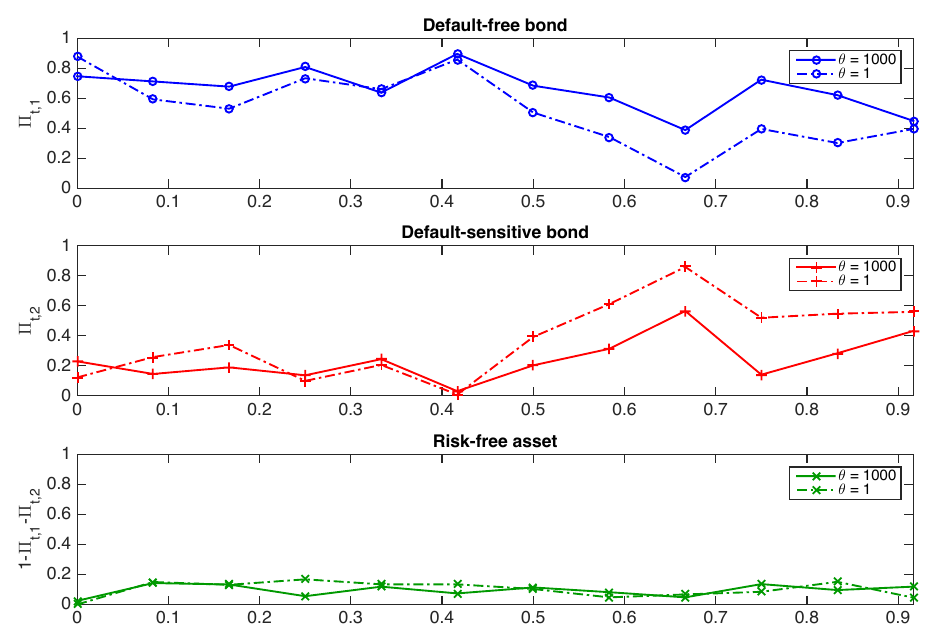
Figure A5. Sensitivity of optimal strategies to a change in θ